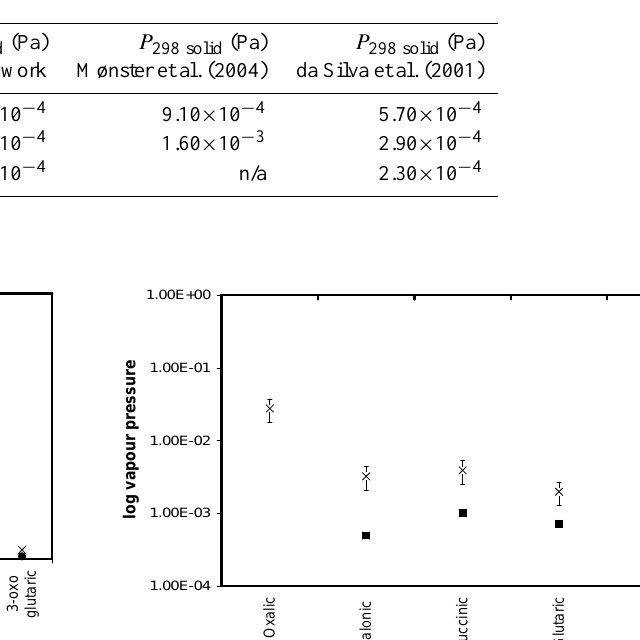
Table 2. Comparison of methyl substituted dicarboxylic acid solid state vapour pressures.